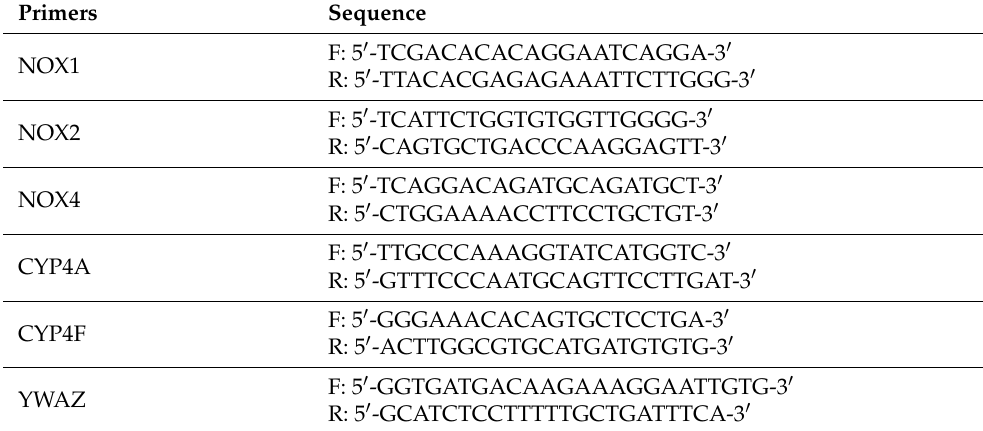
Table 1. Oligonucleotide primer sequences employed for real-time